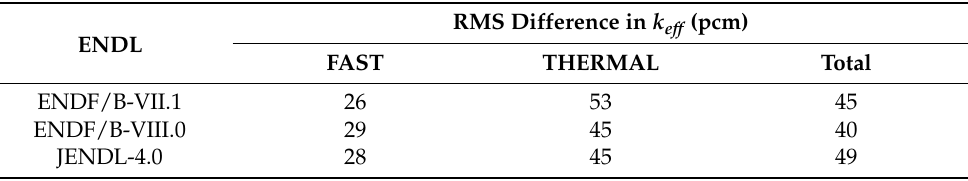
Figure 6. The difference between k eff values by McCARD and MCNP calculations for the selected ICSBEP benchmark problems. Table 7. The RMS difference between k eff results by McCARD and MCNP